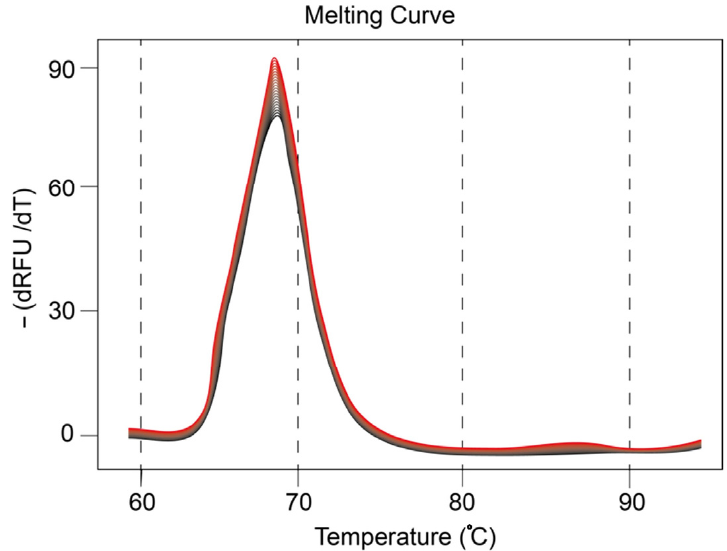
Figure 5. Melting curve of mir21 expression (20 cycles).